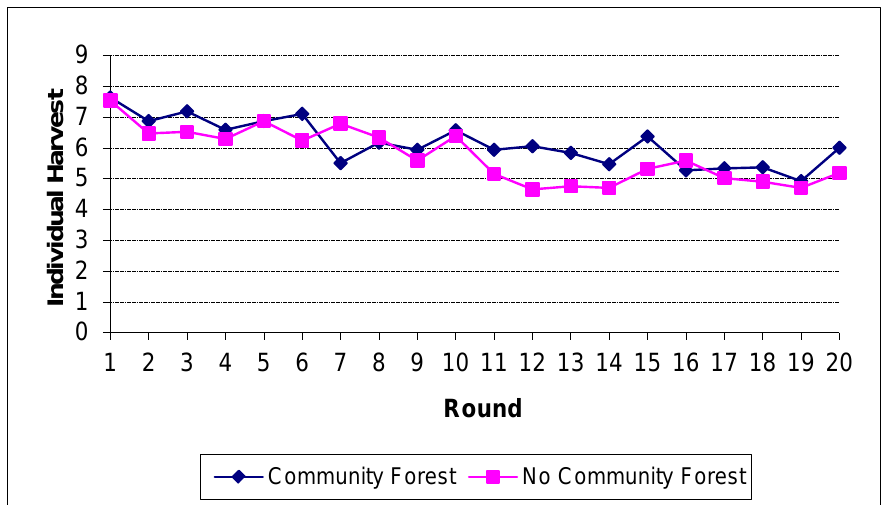
Figure 3. Comparing average individual harvests per round for villages with and without community forests